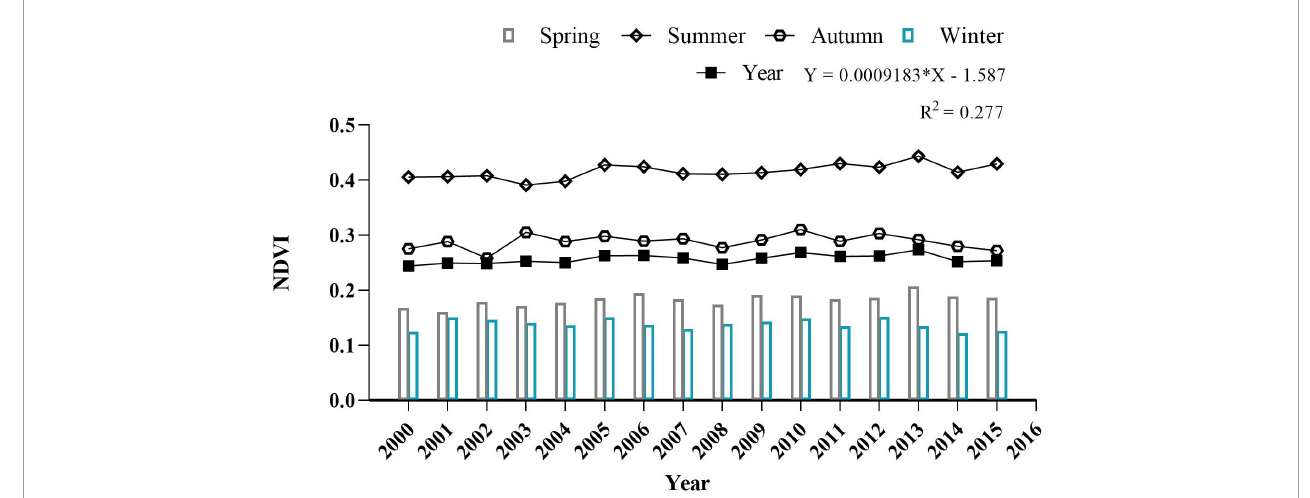
FIGURE4 The change trend of normalized difference vegetation index (NDVI) of alpine wetland vegetation from 2000 to 2015.